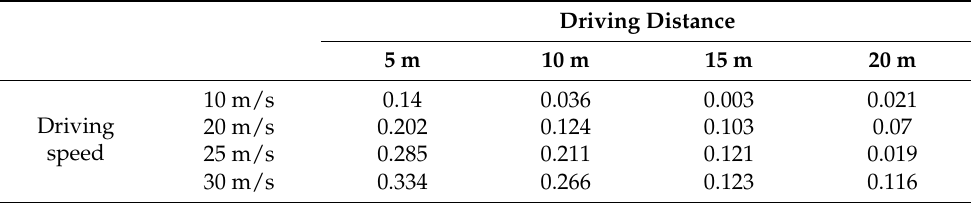
Table 10. Acceleration amplitude for the 28 Hz component in the vehicle’s